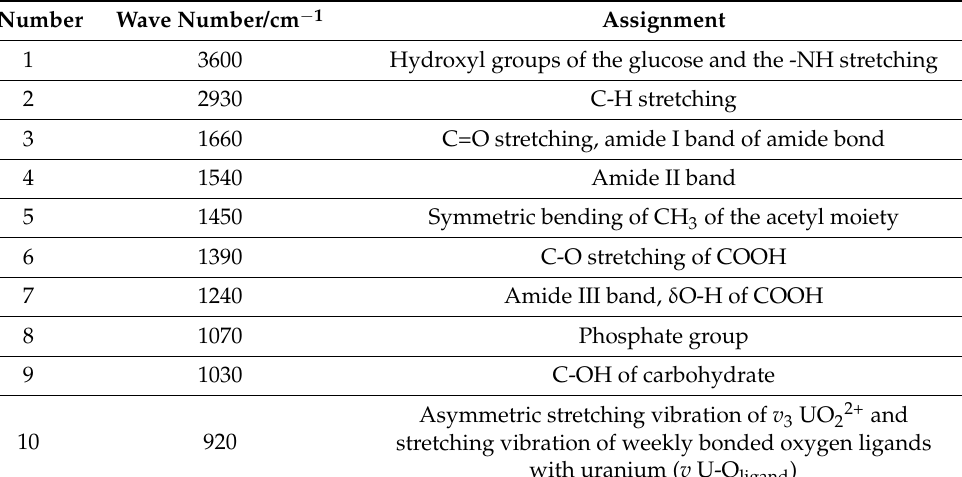
Table 1. Functional groups of the D. radiodurans and the corresponding infrared adsorption